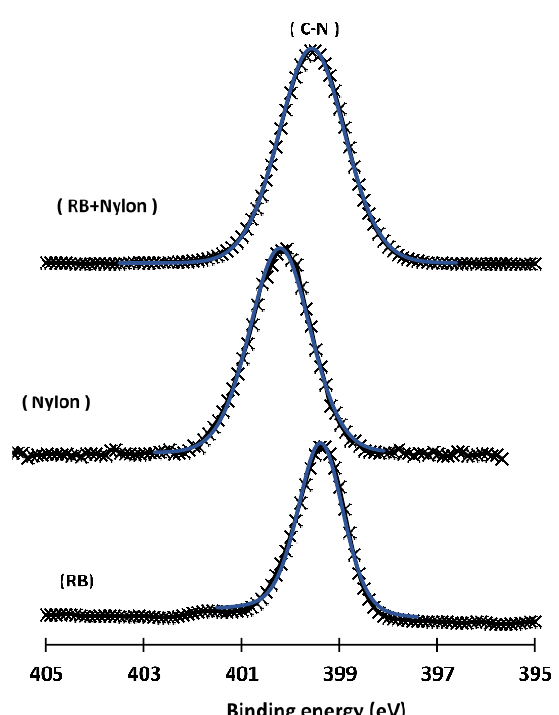
Figure 8. X-ray Photoelectron Spectroscopy (XPS) of N1s regions of rhodamine B (RB), nylon membrane filter (Nylon), and rhodamine B after filtration (rhodamine B + Nylon).